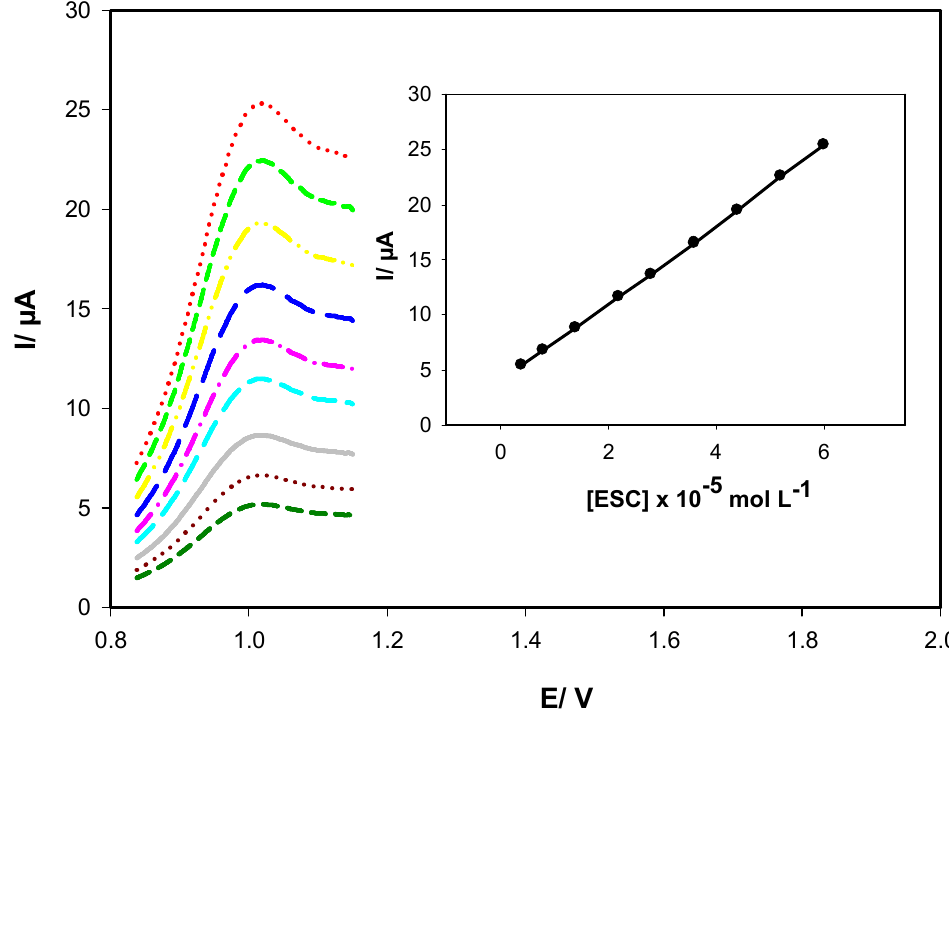
ESI 2: Calibration curve of ESC at NiCACP in urine, pulse amplitude 50 mV, T 100 s and scan rate = 20 mV s -1 . The inset: the plot of anodic current as a function of ESC